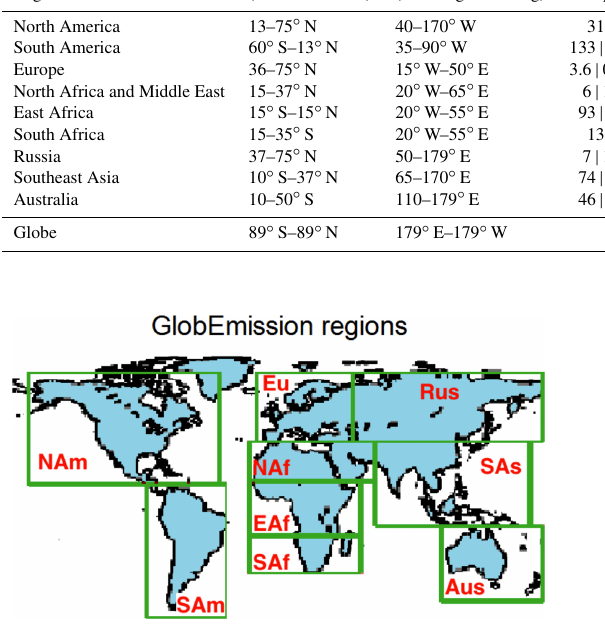
Region (min lat–max lat) (min long–max long) Isoprene Monoterpenes